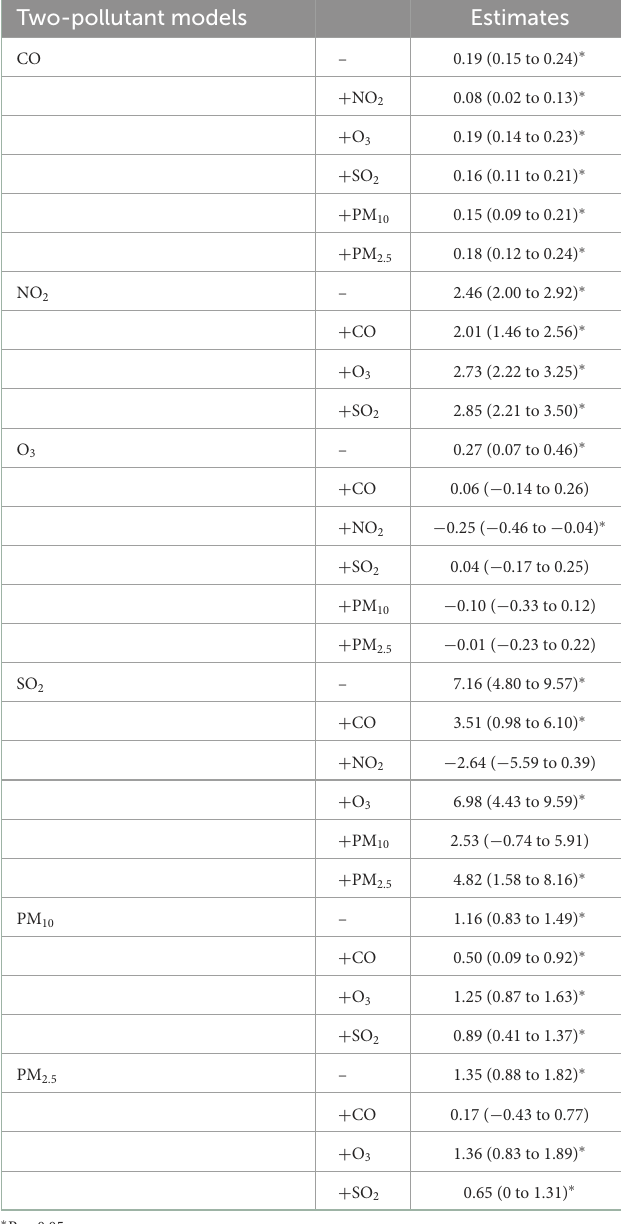
TABLE 4 ER (%) and 95% CI of children’s outpatient visits in co-pollutant models. Two-pollutant models